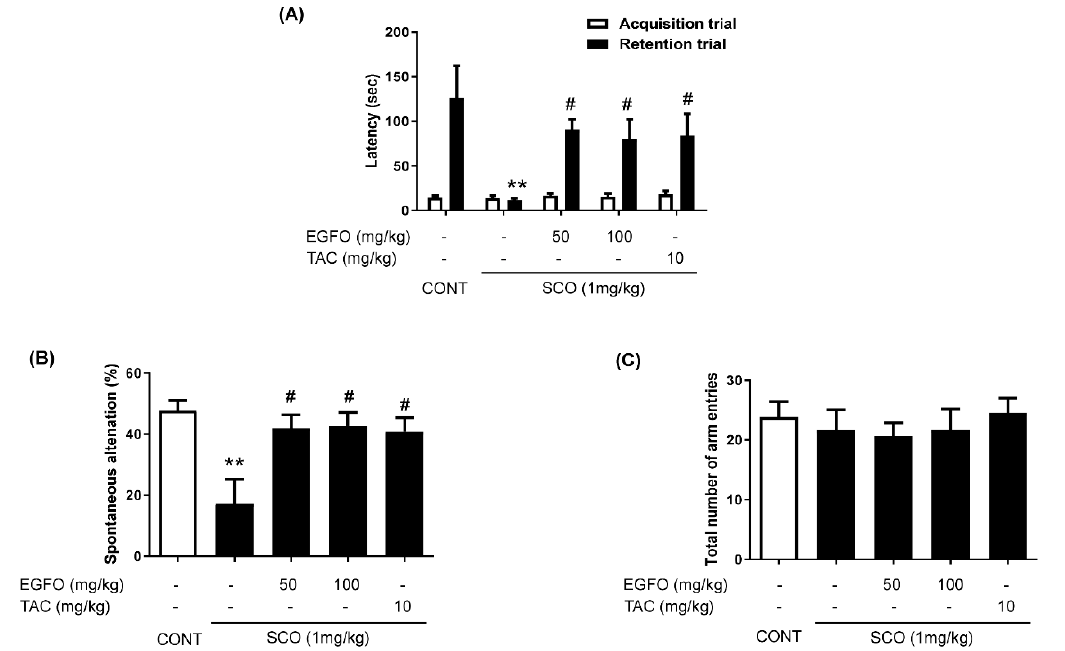
Figure 2. E ff ect of EGFO extract on scopolamine-induced memory impairments . ( A )